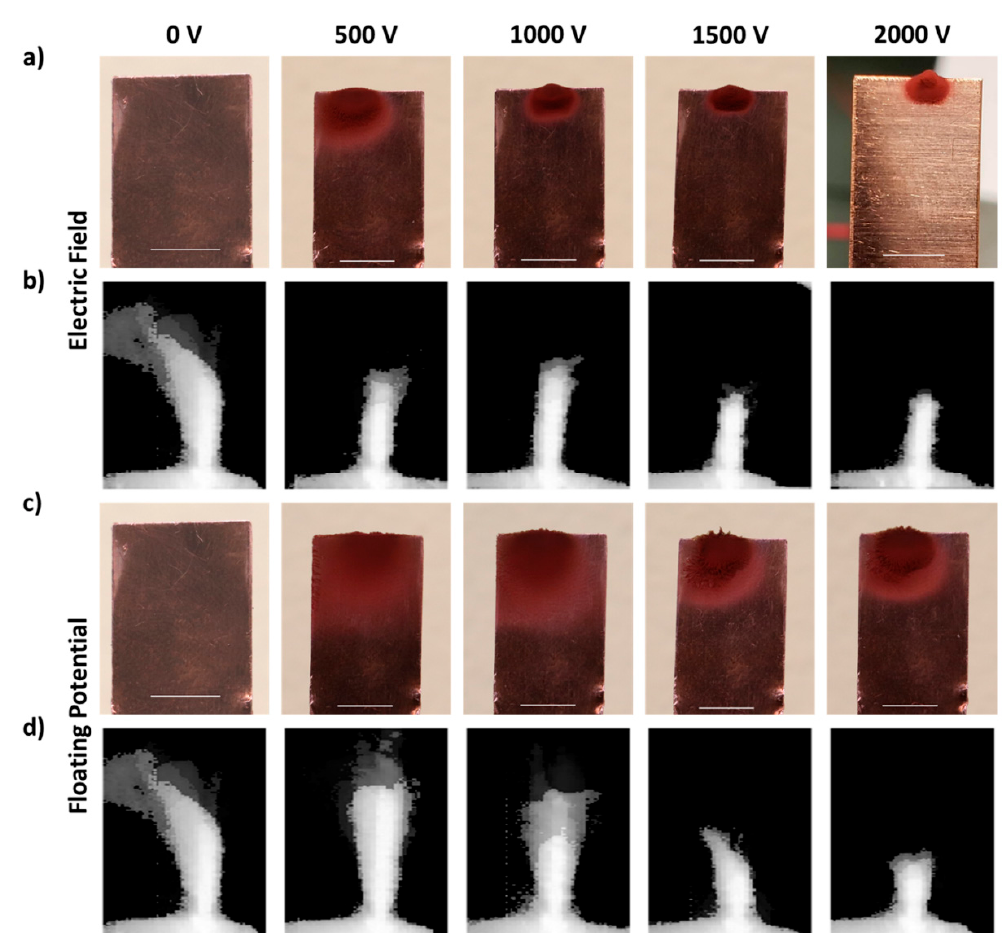
Figure 4. ( a , c ) Photographs of the Cu collection plate after the process of laser machining in the parallel laser scanning direction under variable electric field intensities and floating potential intensities respectively; ( b , d ) images of nanoparticle plume superimposed of 236 frames extracted from the nanoparticle plume filmed during machining under the respective charge condition in the parallel laser scanning direction. The Cu collection plate was located at the top right of the plume image. The scale bars correspond to 5 mm.